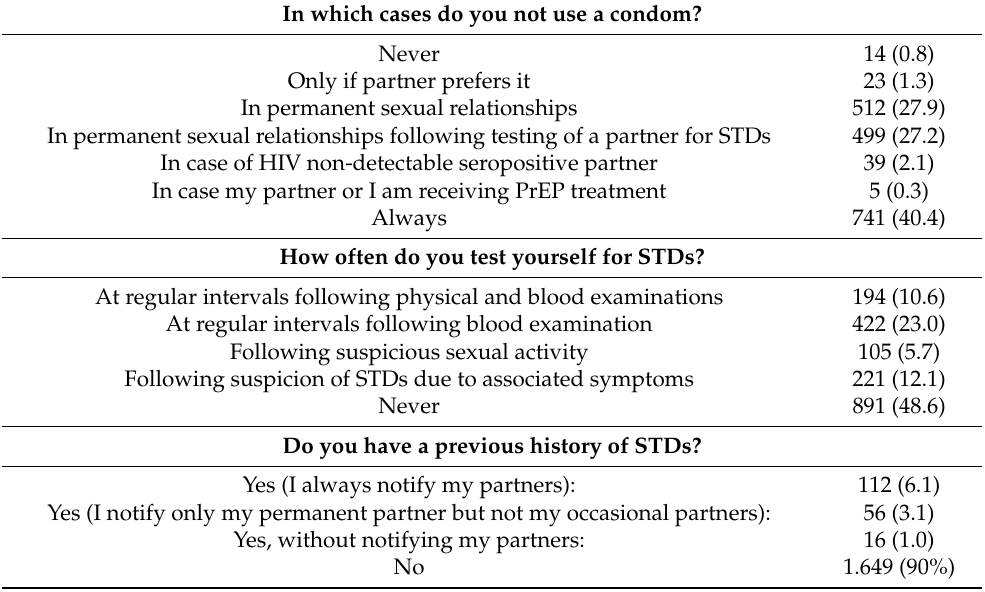
Table 4. Evaluation of sexual behavior-associated